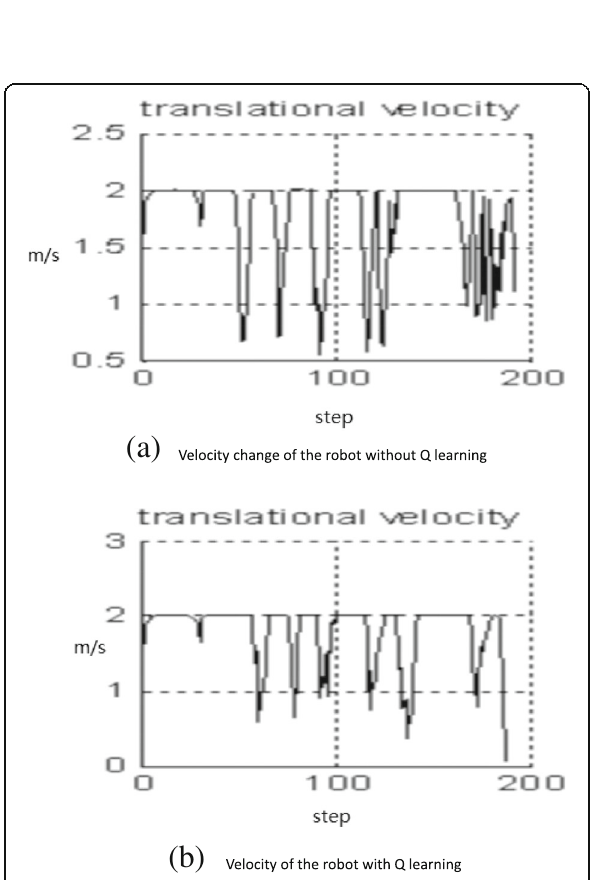
Fig. 4 Comparison chart of speed changes. The vertical coordinate represents the movement speed of the robot (m/s), while the horizontal coordinate represents the number of steps the robot takes (step). The change in the velocity in figure ( a ) of the robot is more gentle than that in figure ( b